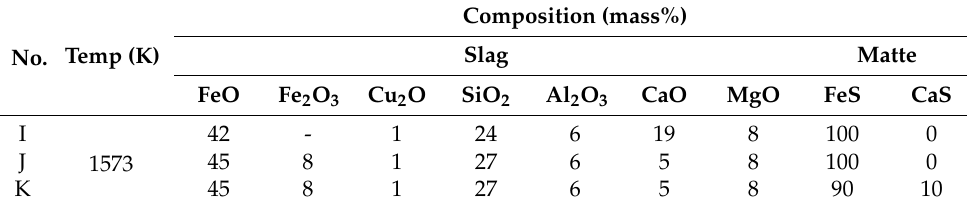
Figure 2. MgO content of the slag as a function of time and the calculated Ak / V value. Table 2. Initial compositions of the slag and matte reported by